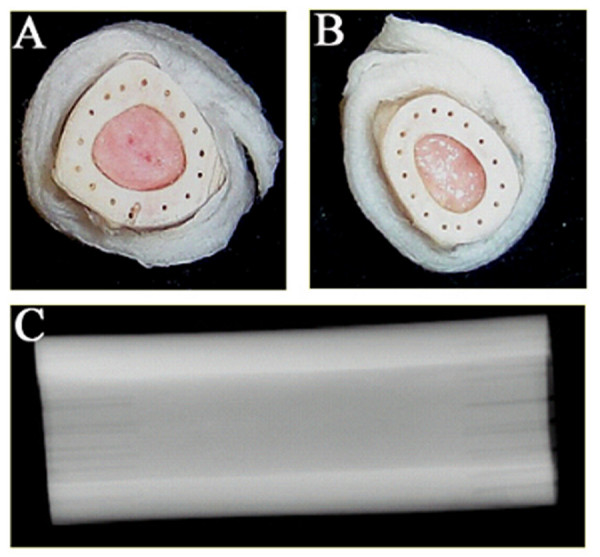
Digital images of perforated 5 cm ovine allografts; (A) proximal and (B) distal perforated end plates illustrate the pattern of 16 conduits that extend 10 mm parallel to the long axis of the allograft; (C) contact radiograph of perforated graft indicating consistency of conduit depth.